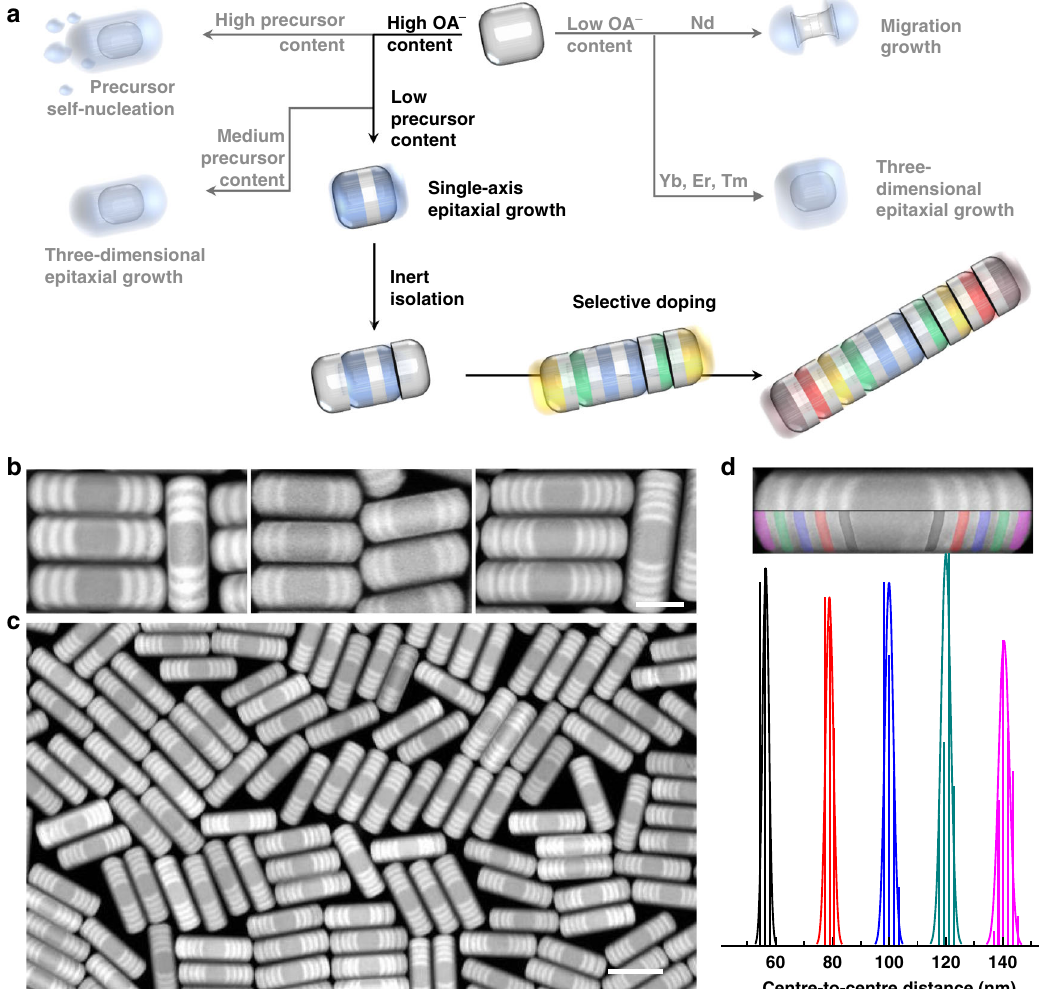
Fig. 1 Single-axis epitaxial controlled growth of heterogeneous nanorods. a Schematic diagram to illustrate the route that leads to the formation of the nanorods. Conditions, including the well-controlled amount of surfactant concentration (OA − ) and the relatively low concentration of shell precursor, have to be met, otherwise, nanoplates, nanodumbbells, and small nanoparticles from precursor self-nucleation, will form. b High-angle annular dark- fi eld scanning transmission electron microscopy (HAADF-STEM) images of three typical heterogeneous nanorods, including 10-segment NaYF 4 -NaErF 4 (10 nm)-NaYF 4 (5 nm)-NaErF 4 (10 nm)-NaYF 4 (5 nm)-NaErF 4 (10 nm), 10-segment NaYF 4 -NaErF 4 (5 nm)-NaYF 4 (5 nm)-NaErF 4 (5 nm)-NaYF 4 (5 nm)-NaErF 4 (5 nm), and 18-segment